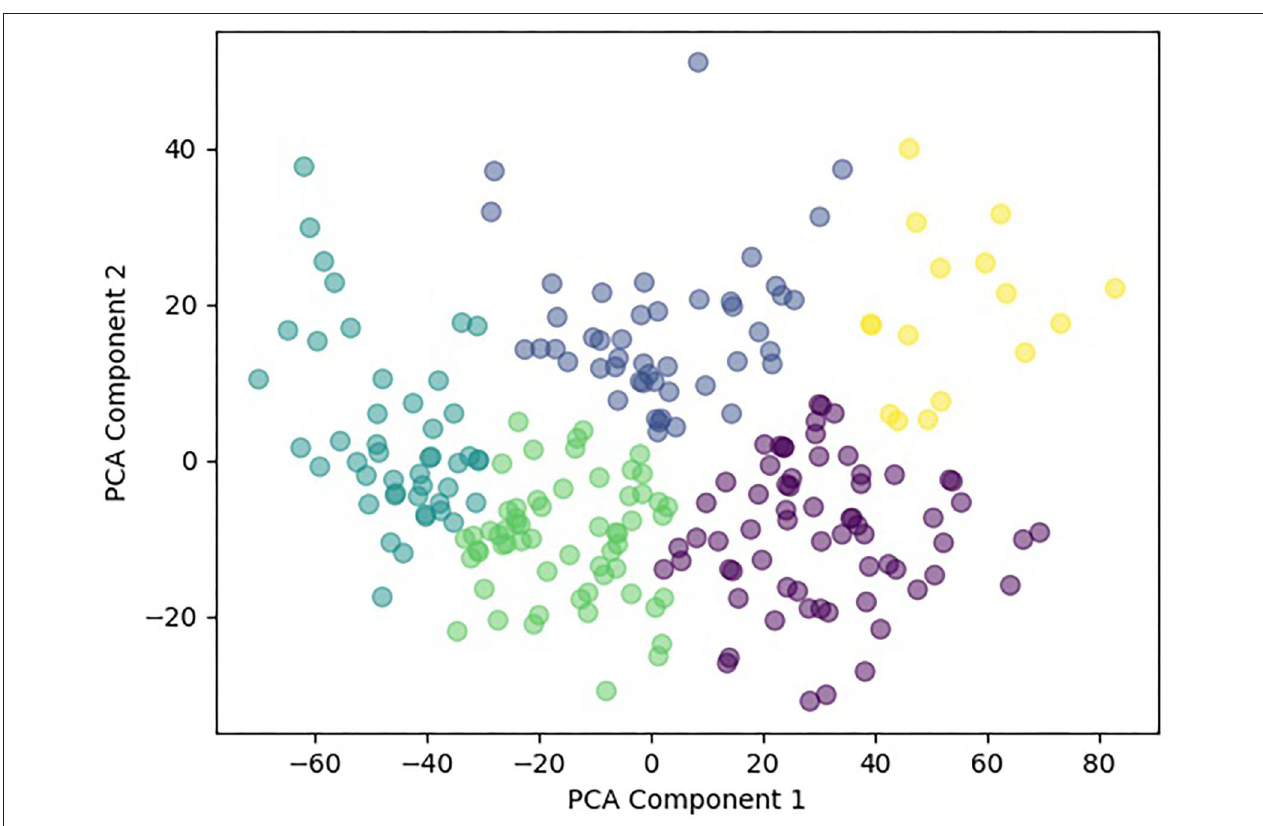
FIGURE 3 | Scatterplot of the formed five clusters.